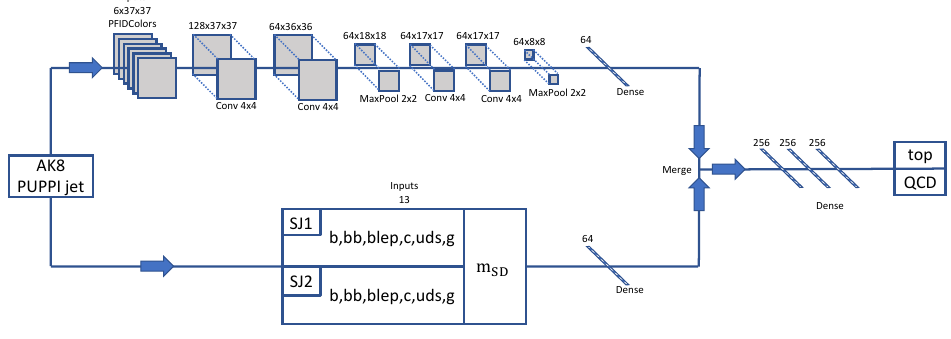
Figure 5. Architecture of the ImageTop CNN